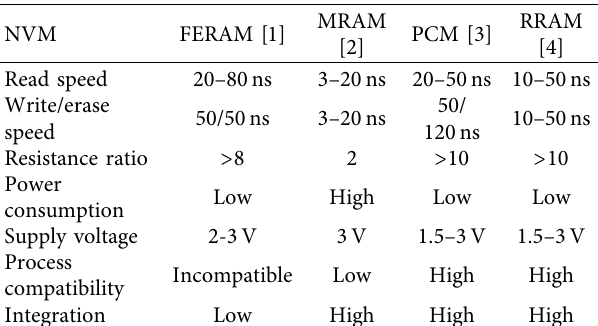
Table 1: Four mainstream NVMs.